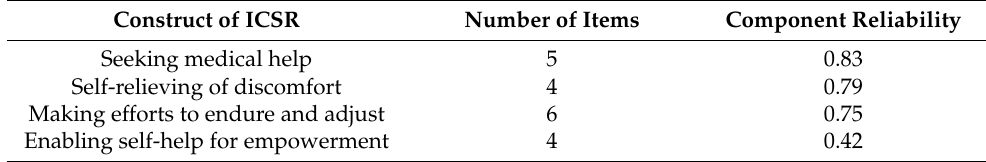
Table 3. Construct reliability of the ICSR.